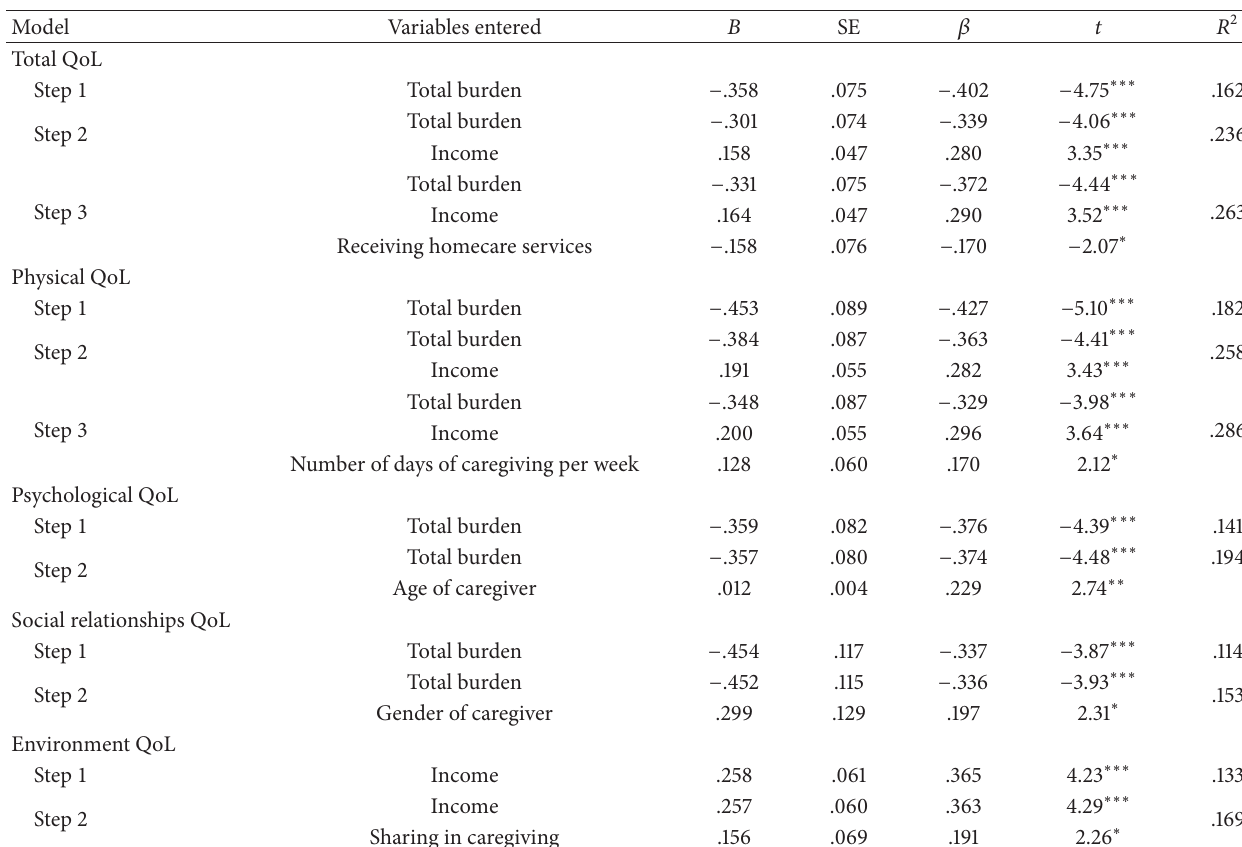
Table 6: Stepwise Regression predicting quality of